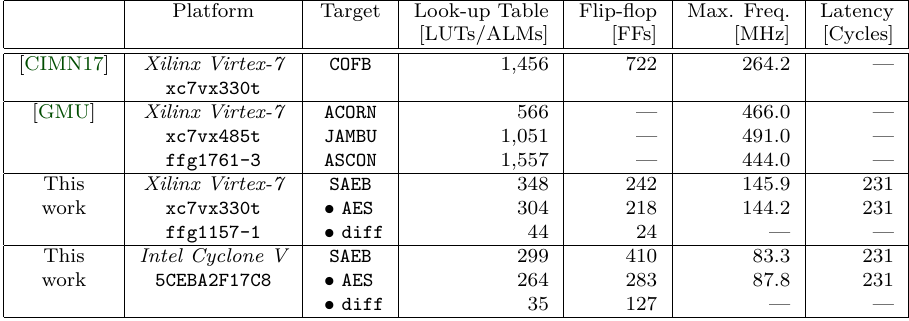
Table 6: Performance of SAEB in